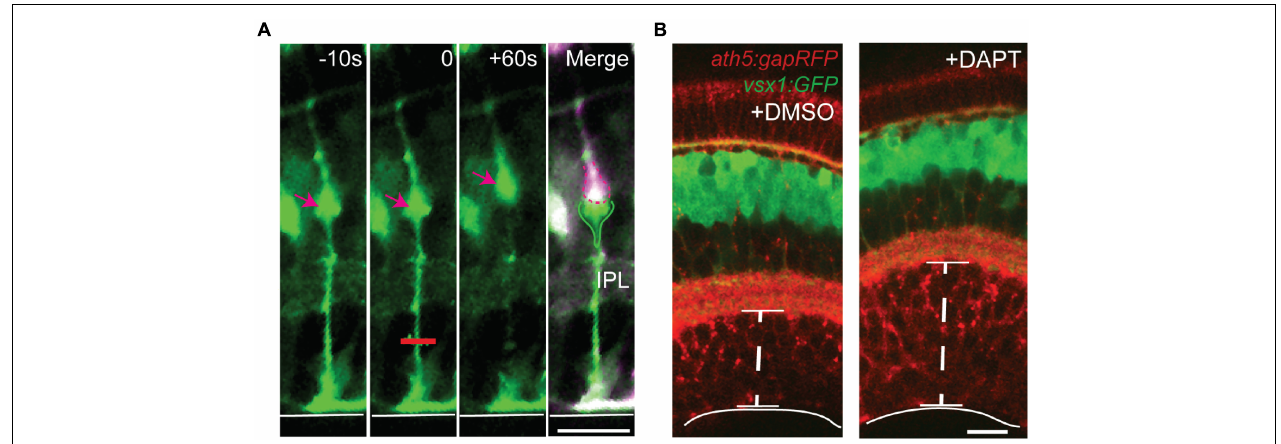
FIGURE 5 | Müller glia act as springs to maintain strength and integrity of the retina. (A) Laser ablation was used to sever the basal processes of GFAP:GFP Müller glia from zebrafish in vivo . After ablation at t = 0 (red line), the basal process retracts and the cell body (arrow) is displaced apically, suggesting that Müller glia are under tension during development. (B) Retinal development in the absence of Müller glia following treatment with the Notch pathway inhibitor DAPT leads to expansion of the ganglion cell layer (GCL) without an increase in cell number, suggesting that tension along Müller glia promotes integrity of the GCL. Retinal neurons are labeled with membrane RFP using ath5:gapRFP , and bipolar cells are labeled with GFP using vsx1:GFP . Scale bars 15 µ m. Adapted from MacDonald et al.